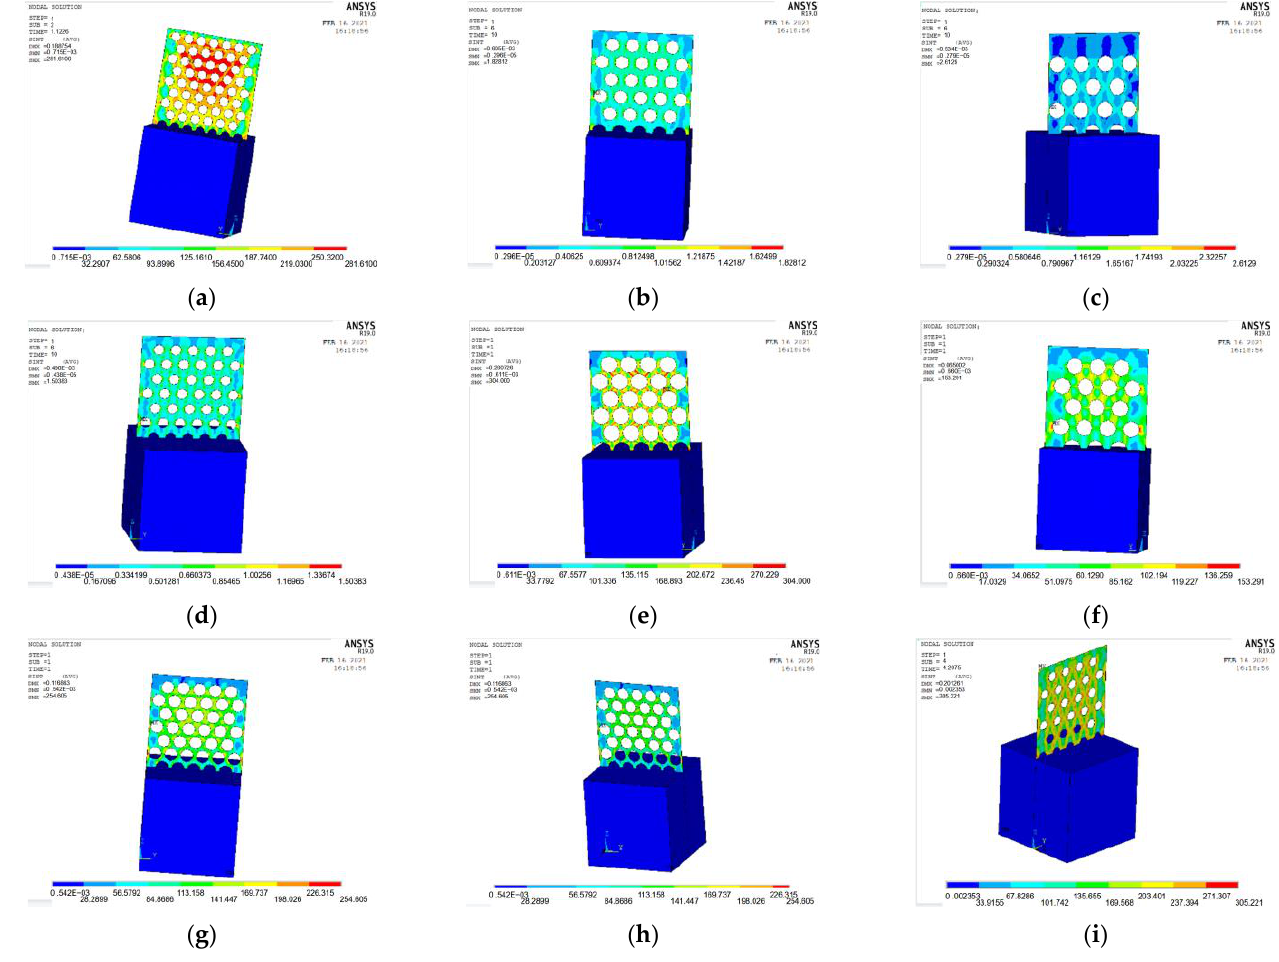
Figure 20. Stress cloud images of nine groups of perforated steel plate reinforced concrete samples: ( a ) test number 1; ( b ) test number 4; ( c ) test number 7; ( d ) test number 2; ( e ) test number 5; ( f ) test number 8; ( g ) test number 3; ( h ) test number 6; ( i ) test number 9.